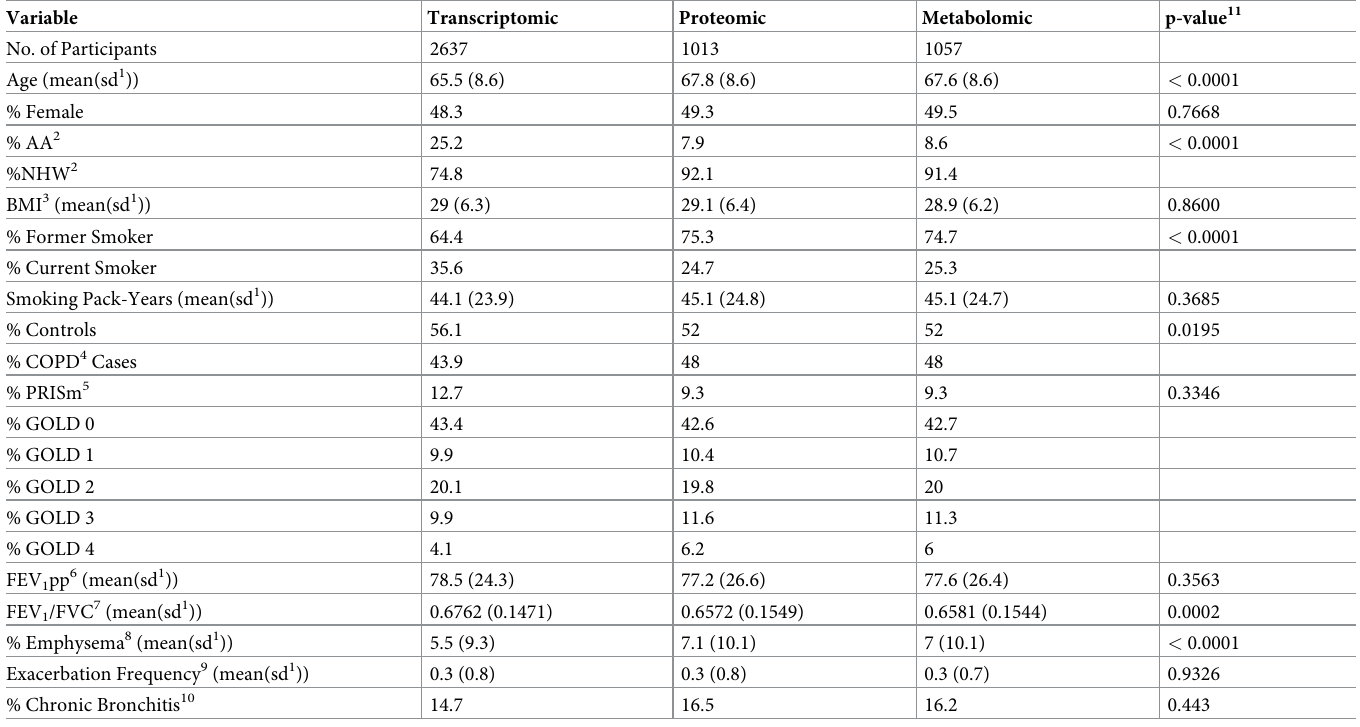
Table 1. Clinical characteristics and demographics for profiled subjects by each of the three -omics technologies.